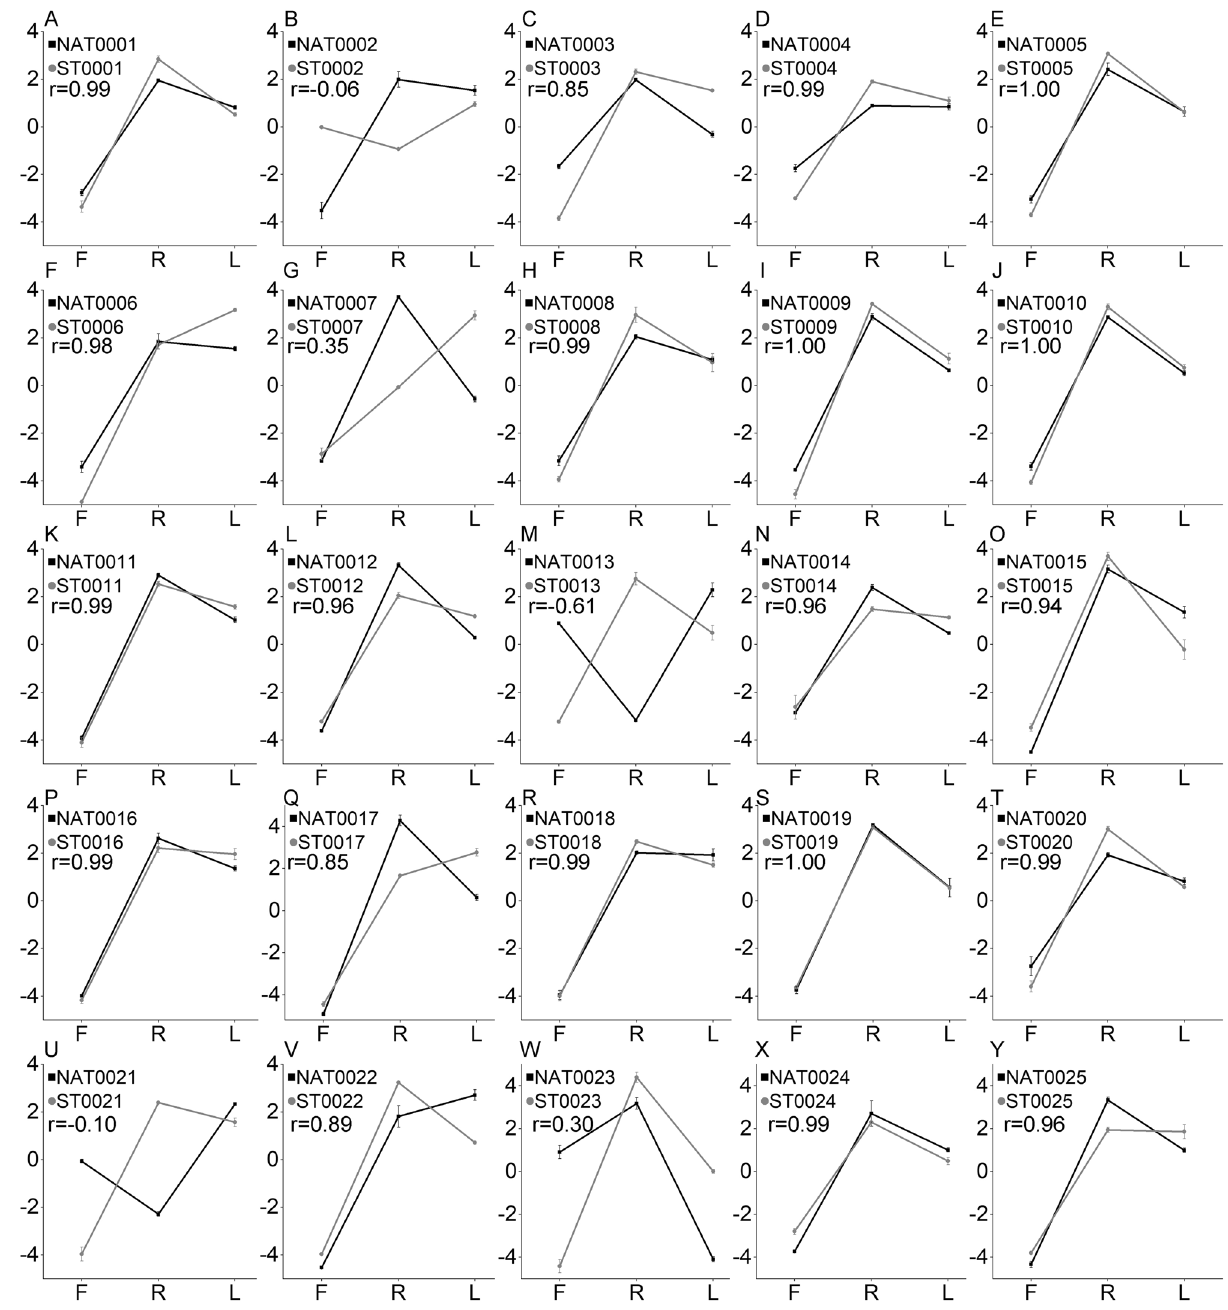
Figure 4. The correlation of expression levels of 25 NAT and ST pairs in flower (F), root (R), and leaf (L) tissues of S. miltiorrhiza . The X-axis shows the three tissues. Y-axis shows relative expression levels of NATs and STs analyzed using the ssRT-qPCR method. Error bars represent the standard error among three replicates. The values of r represent the correlation coefficient of expression levels between NATs and